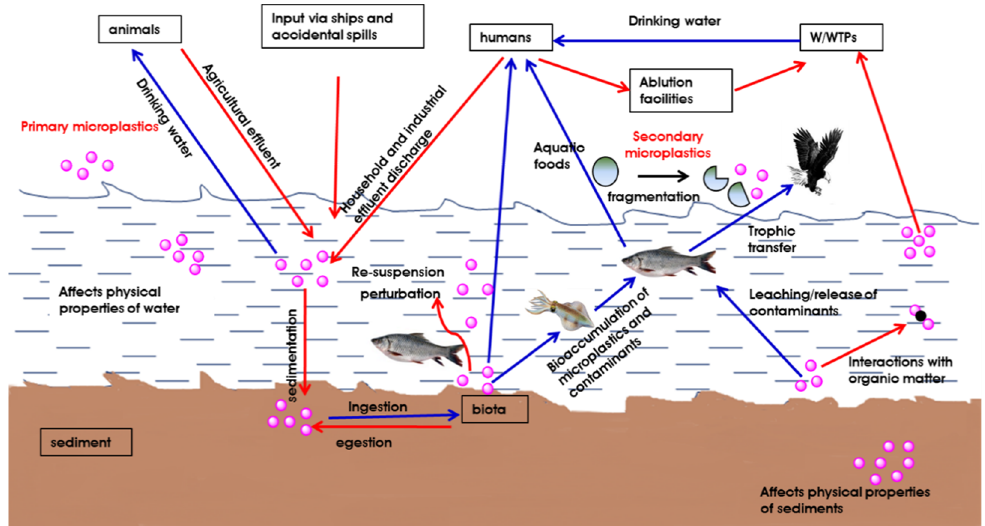
Figure 3. An illustration of the occurrence and fate of microplastics in aquatic systems.